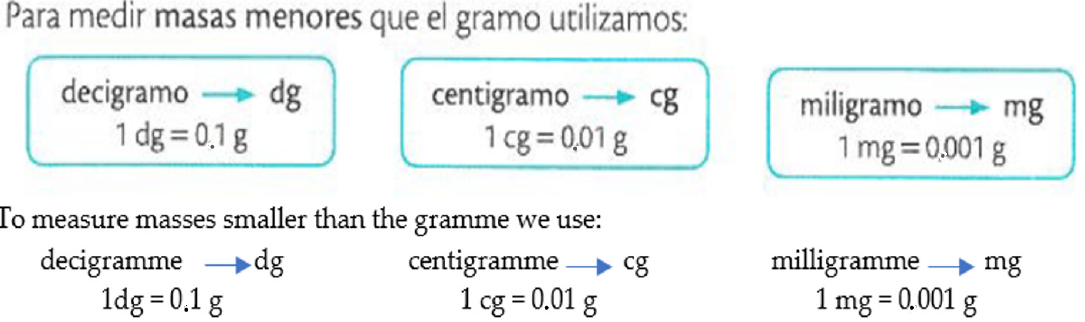
Figure 4. Equivalence between units of measure (4th year mathematics, SM [44]).